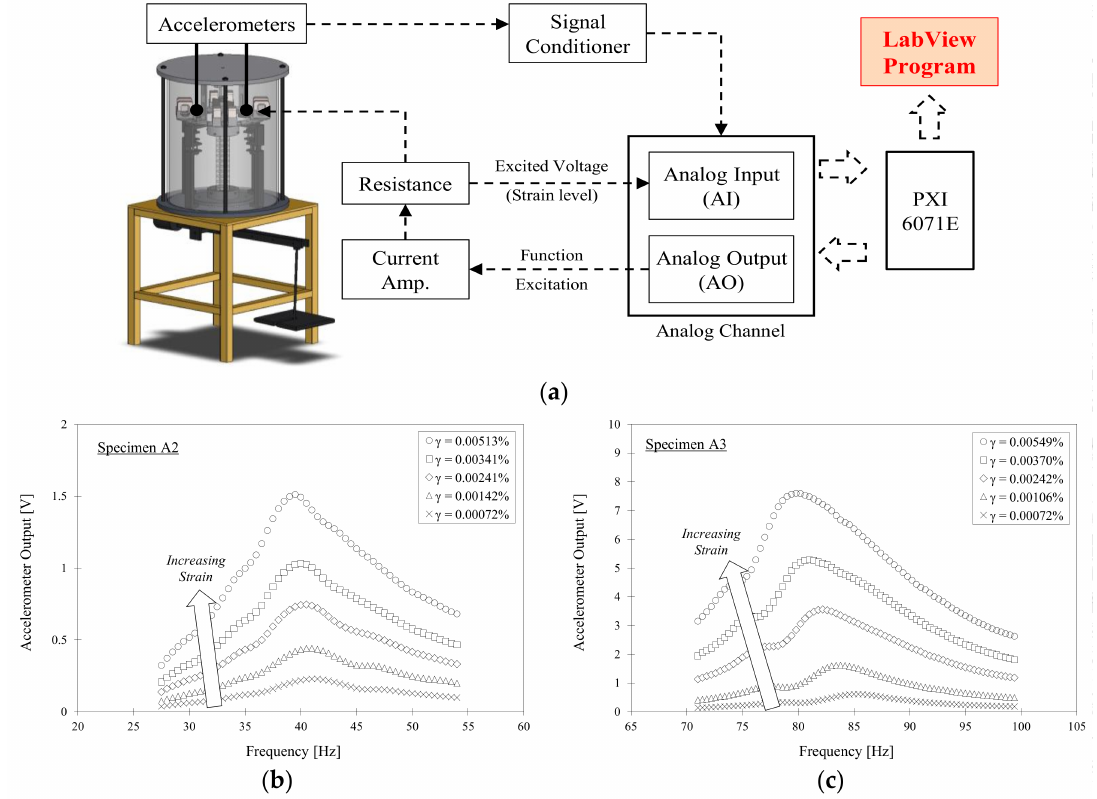
Figure 2. Rock mass dynamic test (RMDT) apparatus. ( a ) Schematic diagram of the test apparatus and data acquisition system (modified from Chong et al., 2014) [22]; ( b ) Frequency response curves for different strain levels (jointed rock specimen); ( c ) Typical frequency domain response curve (grouted rock